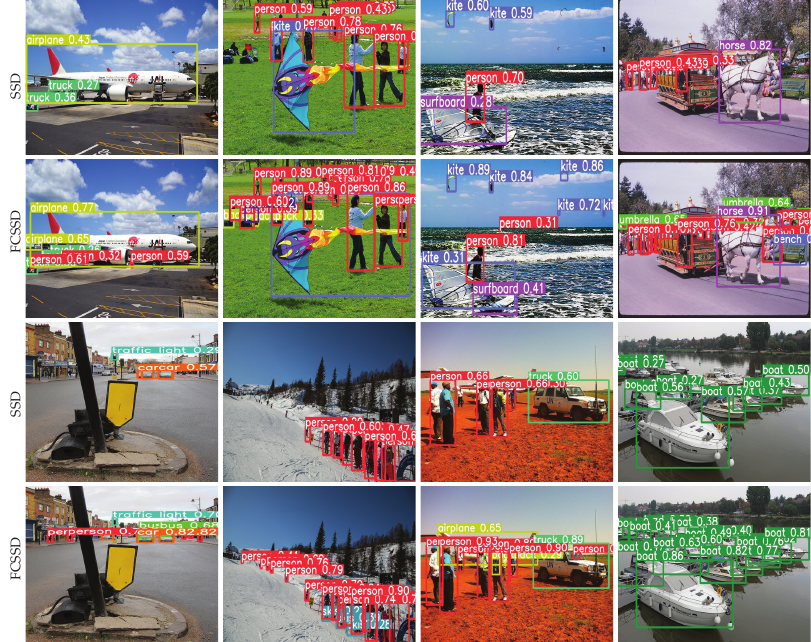
Figure 7. Qualitative results of the SSD in comparison with those of the FCSSD on the PASCAL VOC and MS COCO